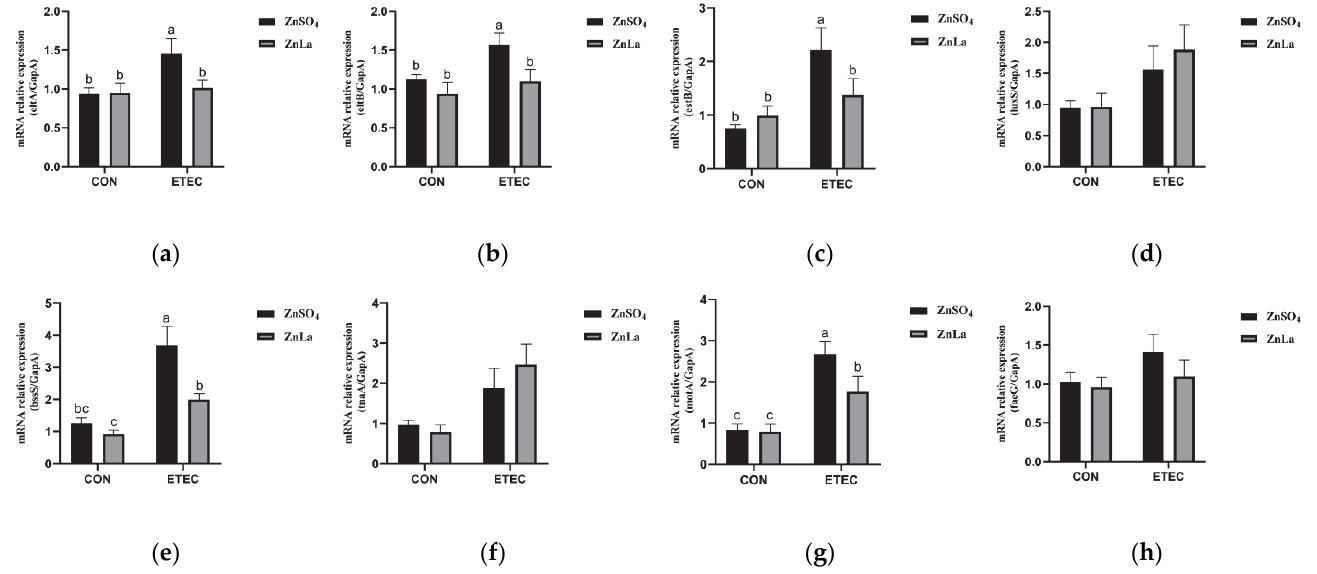
Figure 10. Effects of different zinc sources on virulence gene expression in the cecum content. ( a , b ) LT (eltA and eltB), ( c ) ST (estB), ( d ) quorum sensing (luxS), ( e , f ) biofilm formation (bssS and tnaA), ( g ) motility (motA), and ( h ) cellular adhesion (faeG). The data are expressed as mean ± s.e.m (n = 9), and different lowercase letters in each group show significant differences ( p < 0.05).